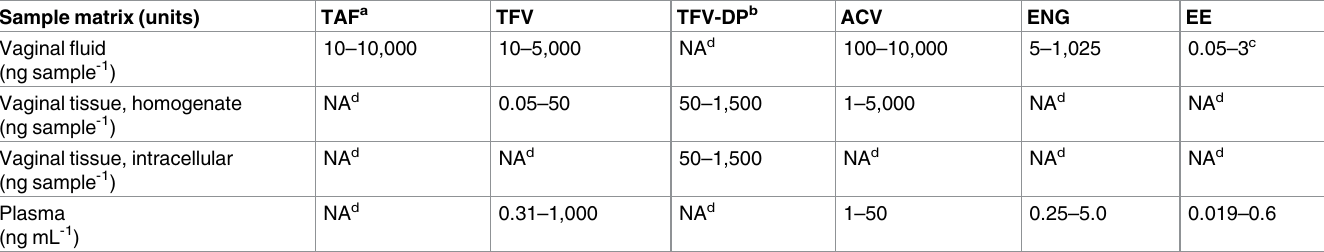
Table 2. Analytical ranges for biological